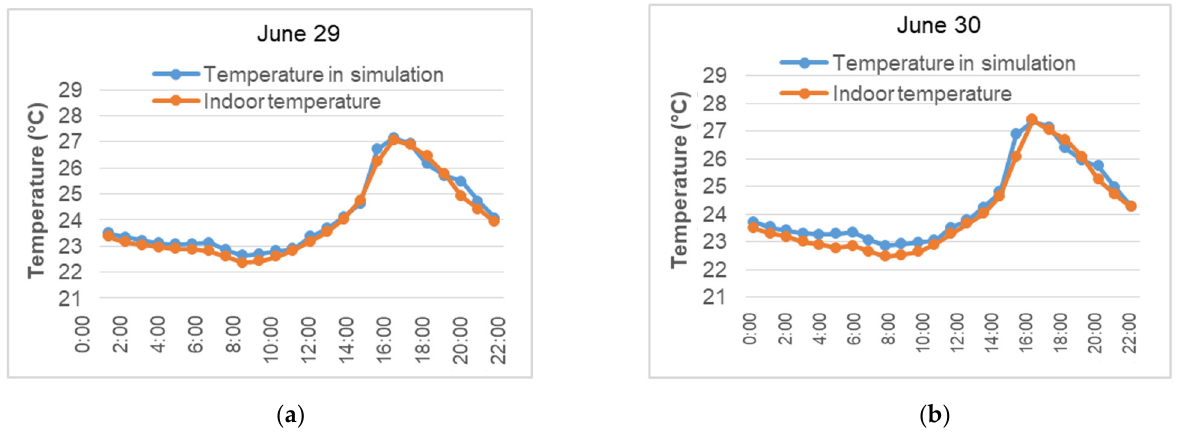
Figure 7. Comparison of the all-day course of internal temperatures from the measured values from the simulation: ( a ) for 29 June, ( b ) for 30 June.